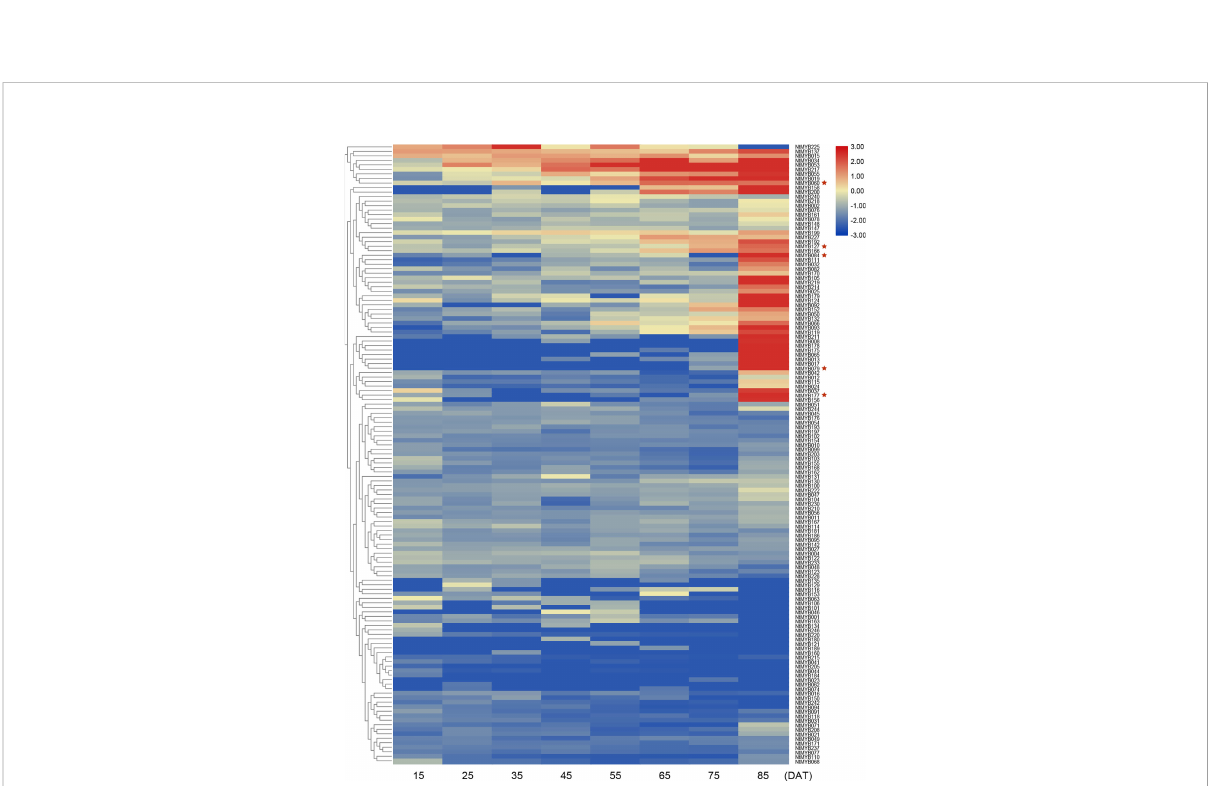
FIGURE 5 Expression pro fi les of the NtMYB genes of middle tobacco leaves in different periods. The example of middle leaf harvested from plants from 15 to 85 DAT (days after topping). The heatmap was constructed based on normalized RNA-seq data of NtMYB genes and visualized by R. Red indicates high expression, and blue indicates no detected expression. H indicates Honghuadajingyuan; M, middle leaves. * indicates the genes mentioned in the